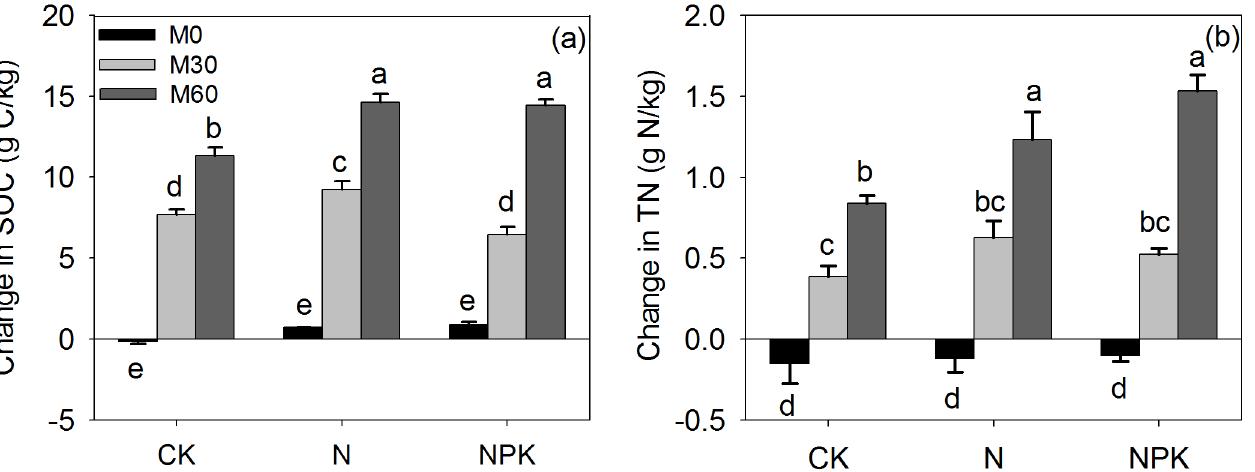
Fig 1. Change in soil organic carbon (SOC, a) and total nitrogen (N) (b) in bulk soil from the control (CK) or soil that has received 32 years of chemical fertilizer application (N, P: phosphorus, K: potassium) and either 0 (M 0 ), 30 (M 30 ) or 60 (M 60 ) t manure ha -1 yr -1 . Note: Different letters above the bars indicate significant differences at 5% probability level. Capped bars are standard error of the mean (n = 3).